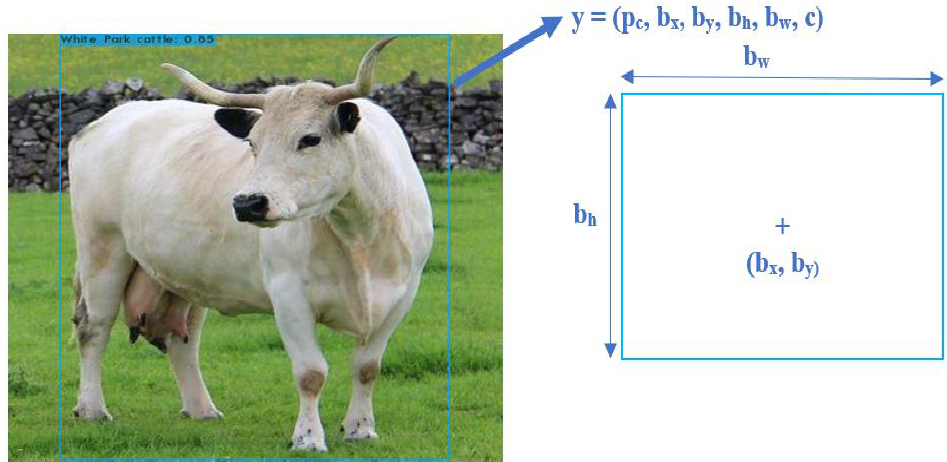
Figure 2. Parameters describing the bounding box.